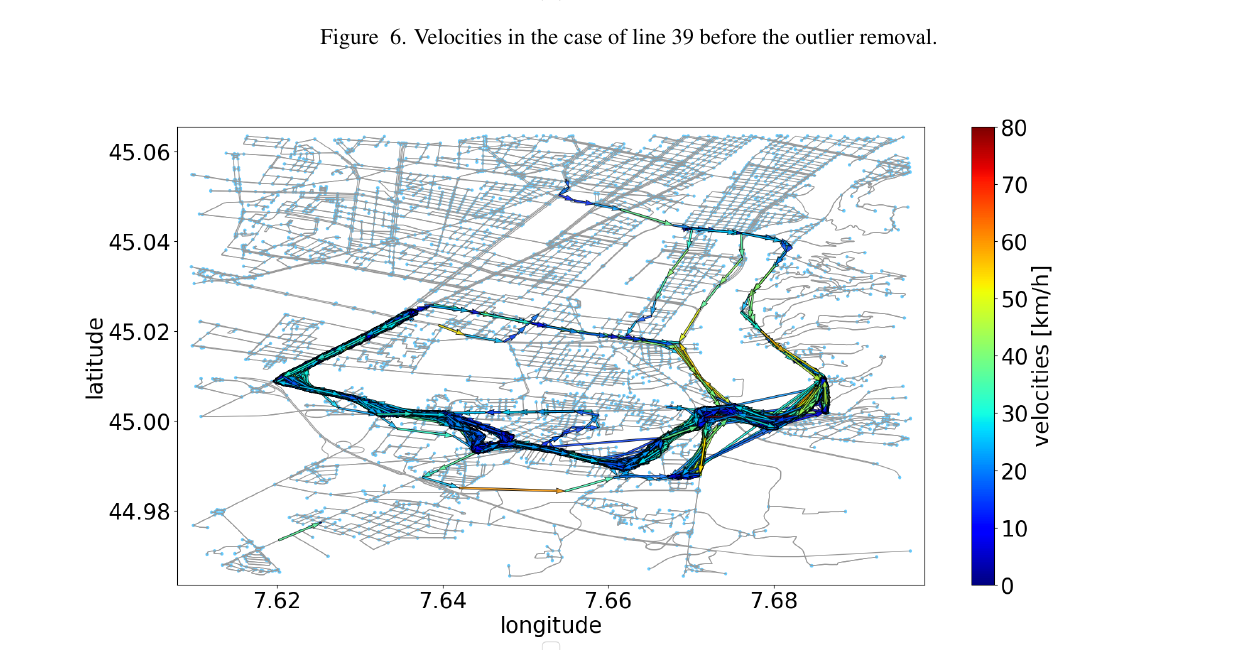
Figure 7. Velocities in the case of line 39 after the outlier